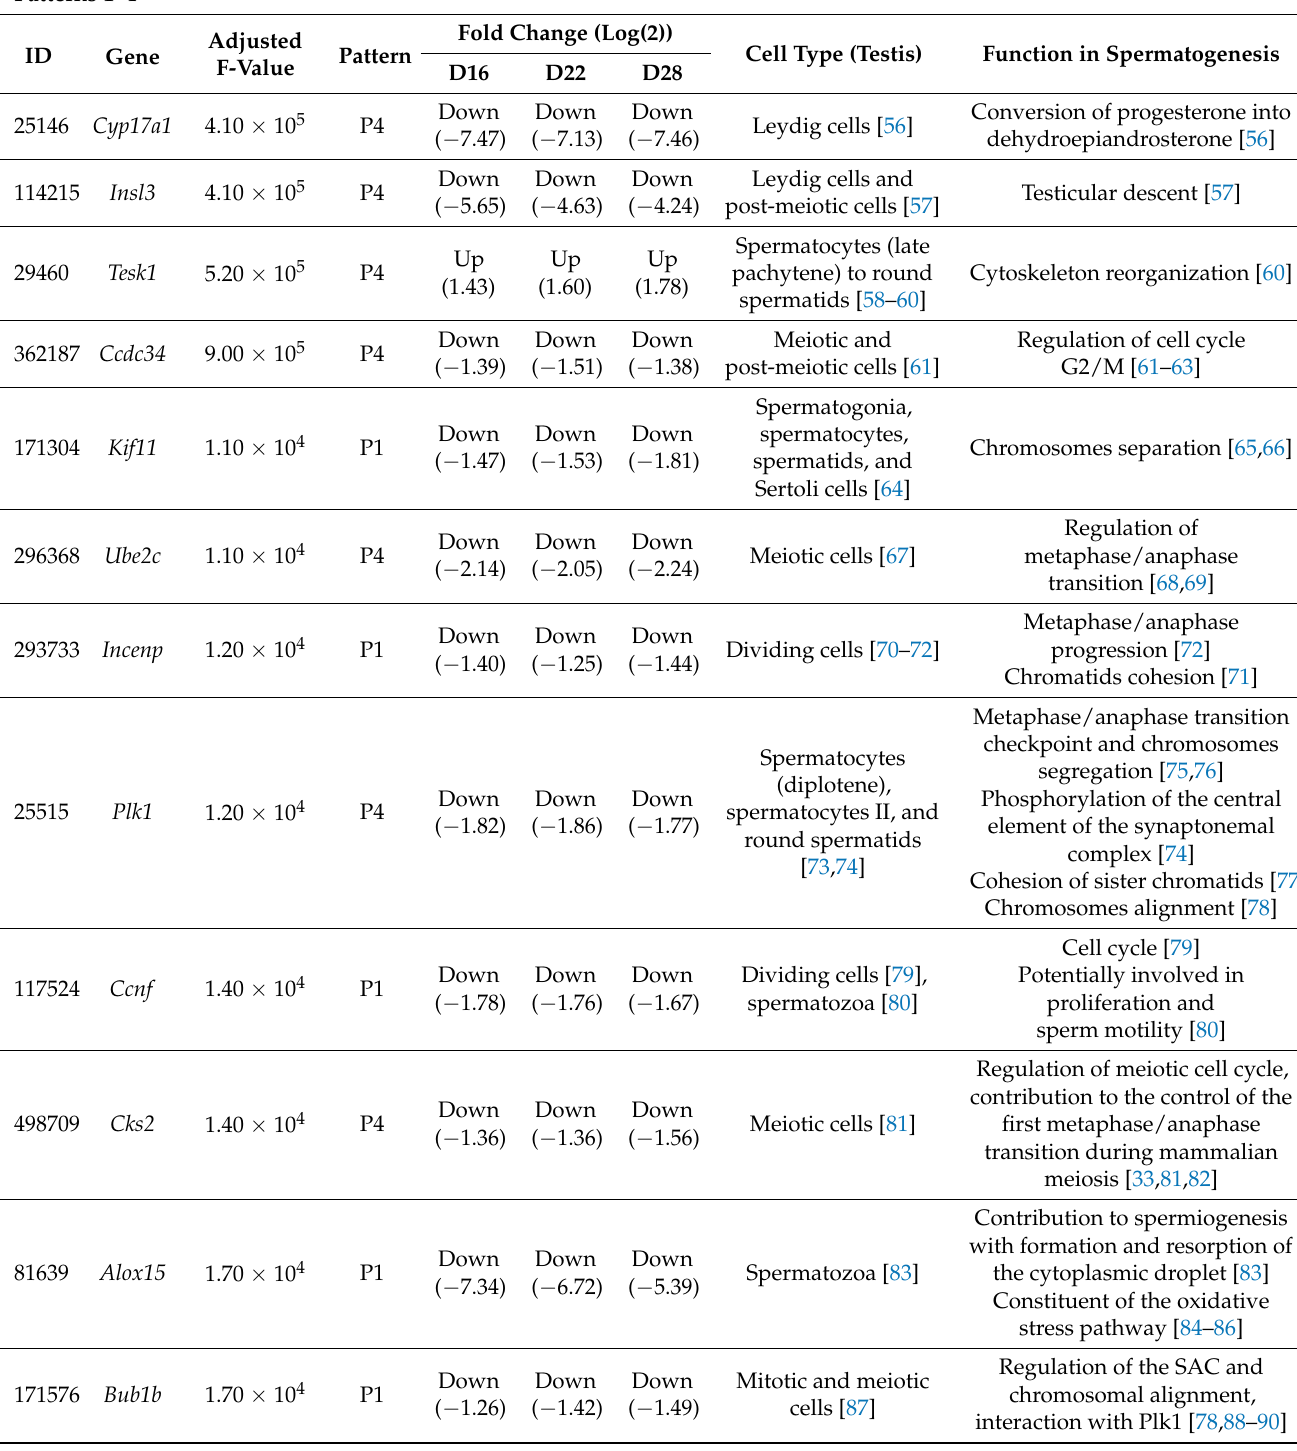
Table 1. Biological information of the top 15 DEGs in each pattern (1–4 and 5–7) related to spermato- genesis. SAC—spindle assembly